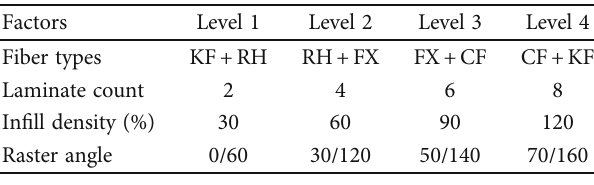
Figure 2: Natural fi bers with PLA laminated structure. Table 1: Process parameters and their values of biocomposite preparation.